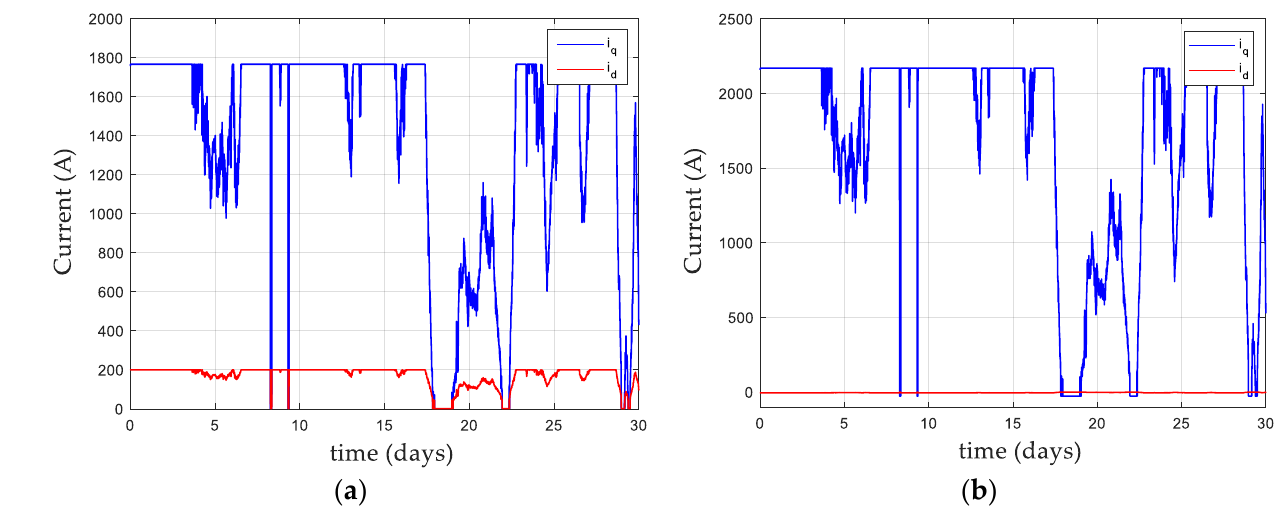
Figure 8. Evolution of the optimal d–q axis currents for q = 3: FW ( a ) and MTPA ( b ). comparison. The following material costs were considered [25]: 50 EUR/kg for the magnets, 3 EUR/kg for iron and 15 EUR/kg for copper. As it can be seen, machines optimized considering a MTPA control are less expensive compared to the machines optimized considering an FW control (28% and 18% for q = 3 and q = 5, respectively). Such a result is mainly due to the volume of magnets, lower for the MTPA, which represents a significant part of the cost of the machine. This difference is in agreement with (16) and (18), where